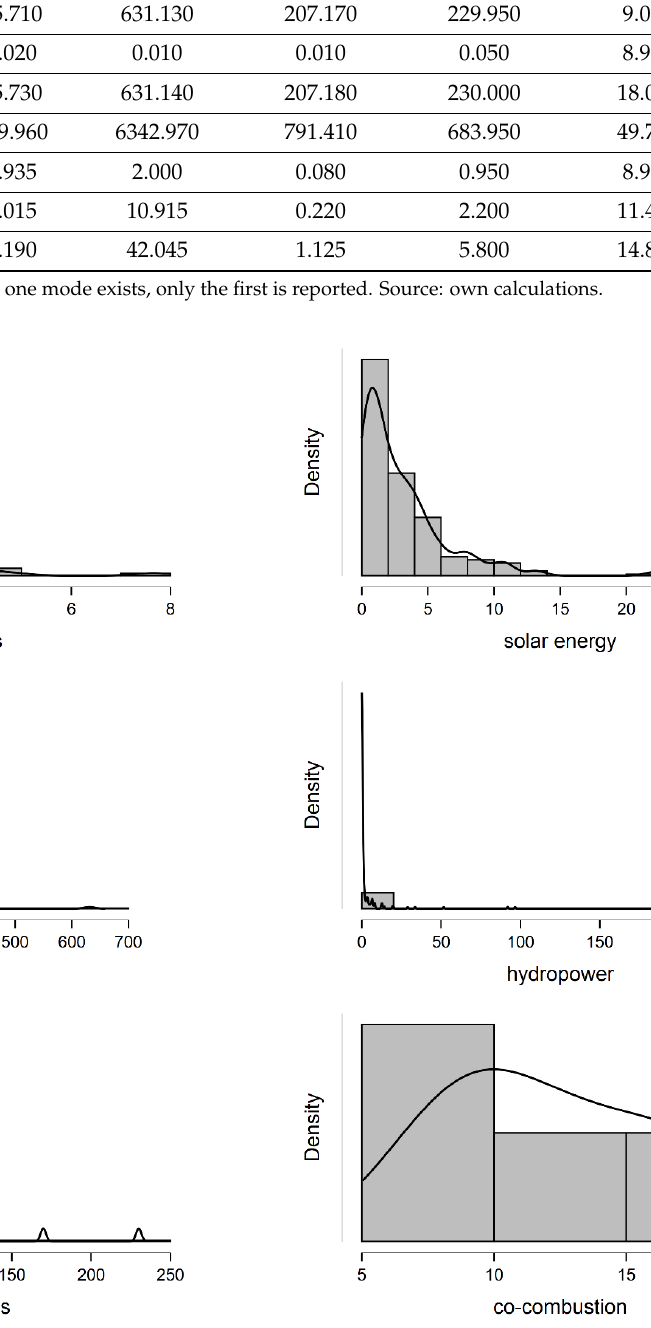
Figure 5. Density distribution of renewable energy generation installations in districts of Poland in 2020. Source: own calculations.